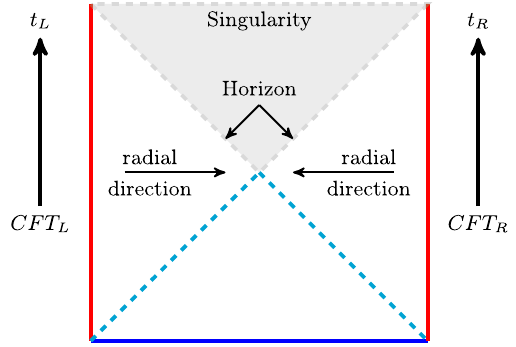
Fig. 5 Comparisonbetweentheregulartwo-loopLEandthefour-loop LE. The former shows immediate decay after perturbation, while the latter exhibits an initial plateau regime